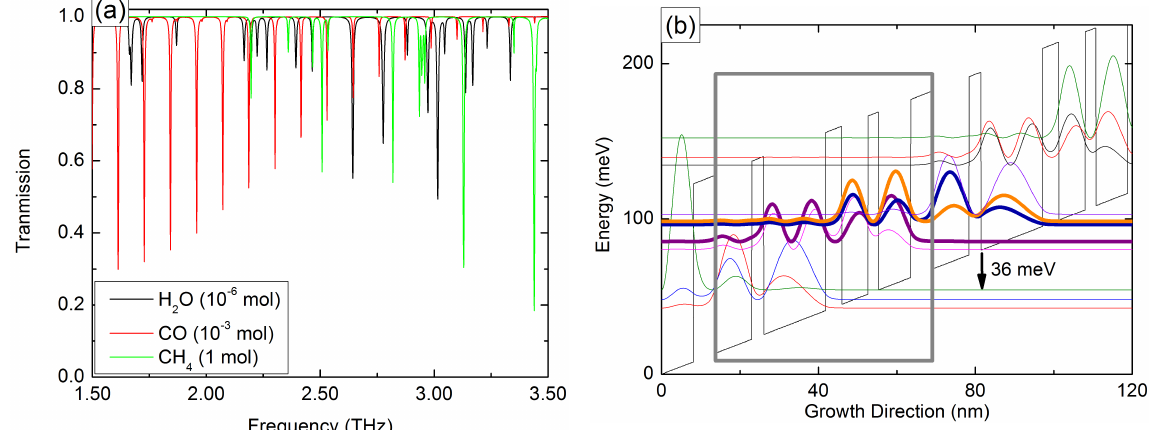
Figure 1. (a) Transmission of water vapor, methane, carbon monoxide at room temperature and 1 bar [16]. The individual absorption lines are clearly visible. (b) Calculated bandstructure of the THz-QCL. One cascade is marked with the gray box. The growth sequence in nanometers is 9.2/ 3.0 /15.5/ 4.1 /6.6/ 2.7 /8.0/ 5.5 , where the Al are marked with bold letters. The lower lasing state is depopulated by a resonant longitudinal optical